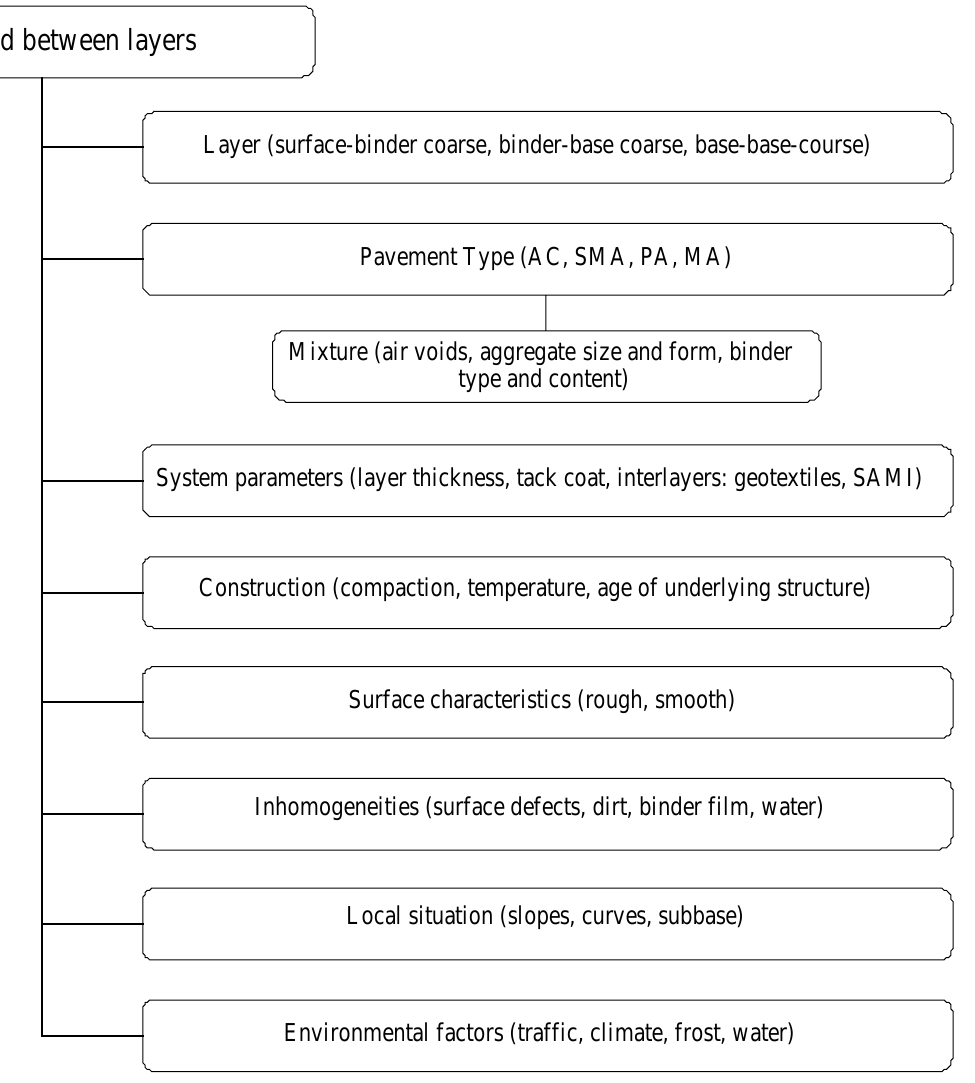
Fig 2. Factors influencing a durable bond between layers